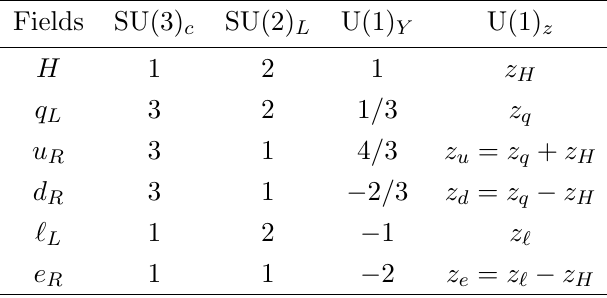
Table 1. The U(1) z charge assignments of the Higgs doublet and the fermions of the